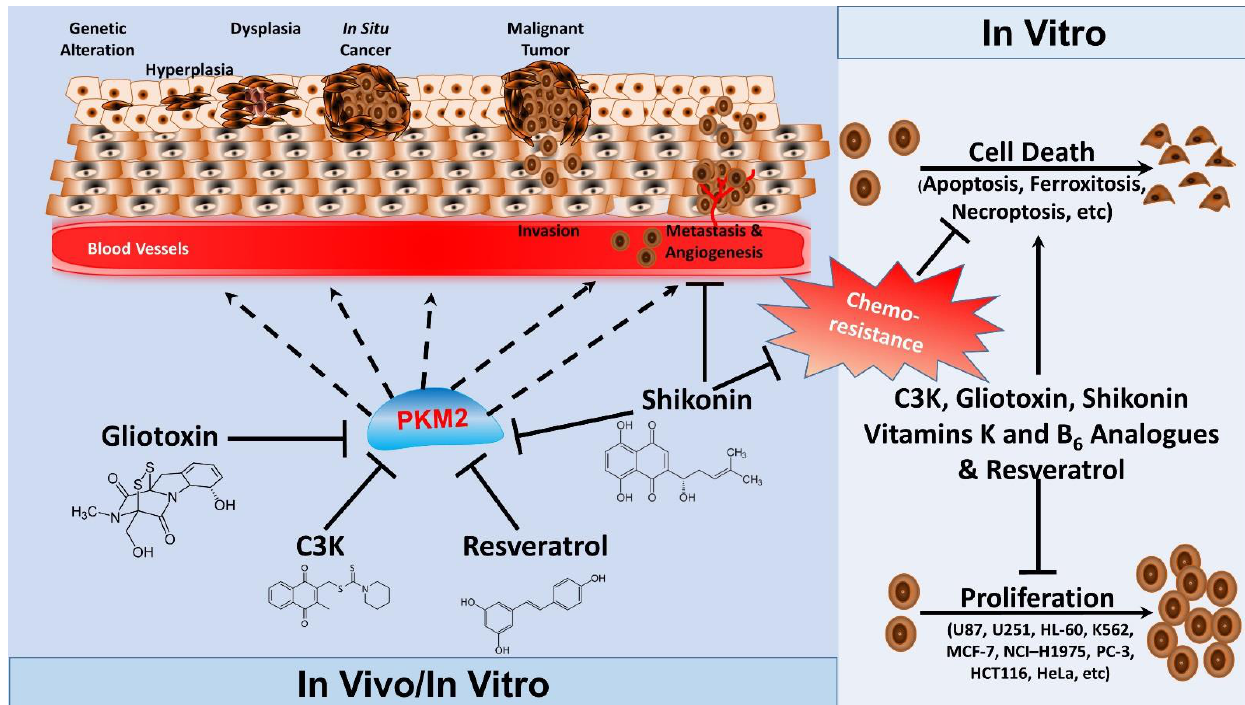
Figure 3. Potential in vivo and in vitro effects of selected natural and pharmacological PKM2 inhibitors.